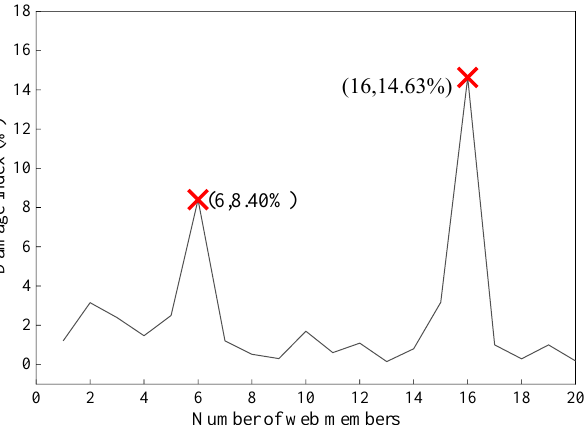
Figure 15. Multi-point damage detection results based on the vehicle loads with 5% noise.